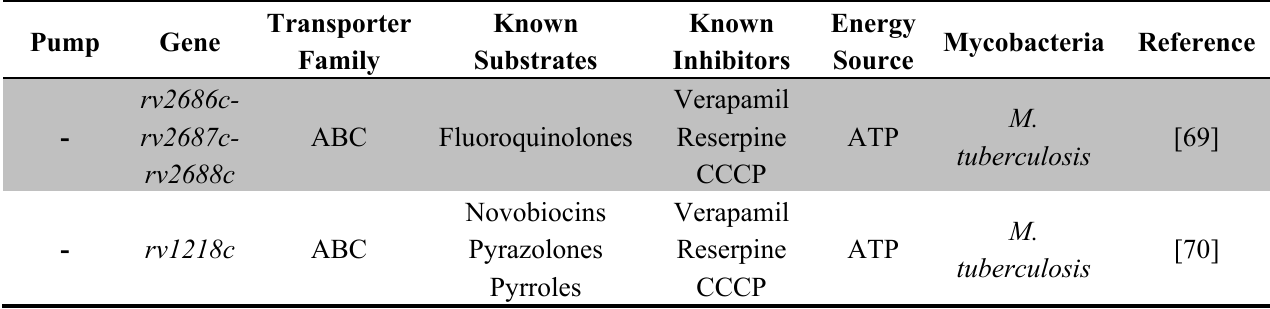
Table 3. Summary of known antibiotic substrates of several mycobacterial efflux pumps of M.